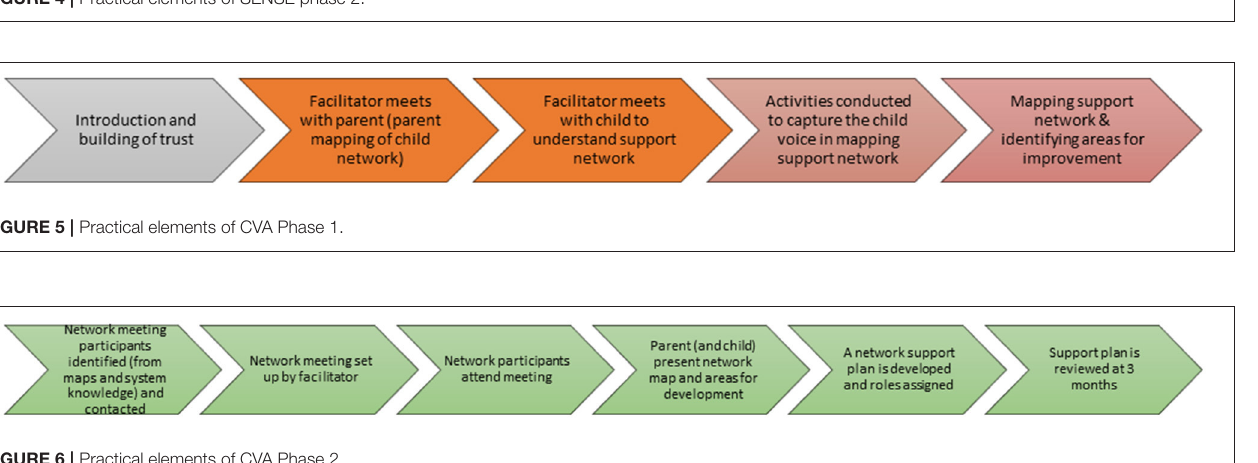
FIGURE 4 | Practical elements of SENSE phase 2.